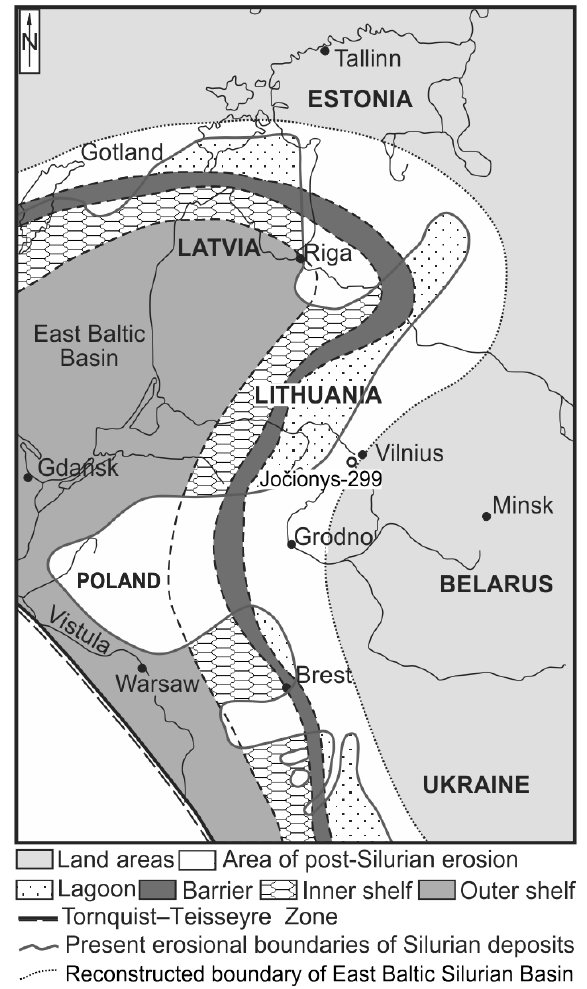
Fig. 1. Paleogeographic map of the East Baltic Silurian Basin Platform during the time of Gothograptus nassa (Homerian, Wenlock) (Einasto et al. 1986) and location of the Jo č ionys-299